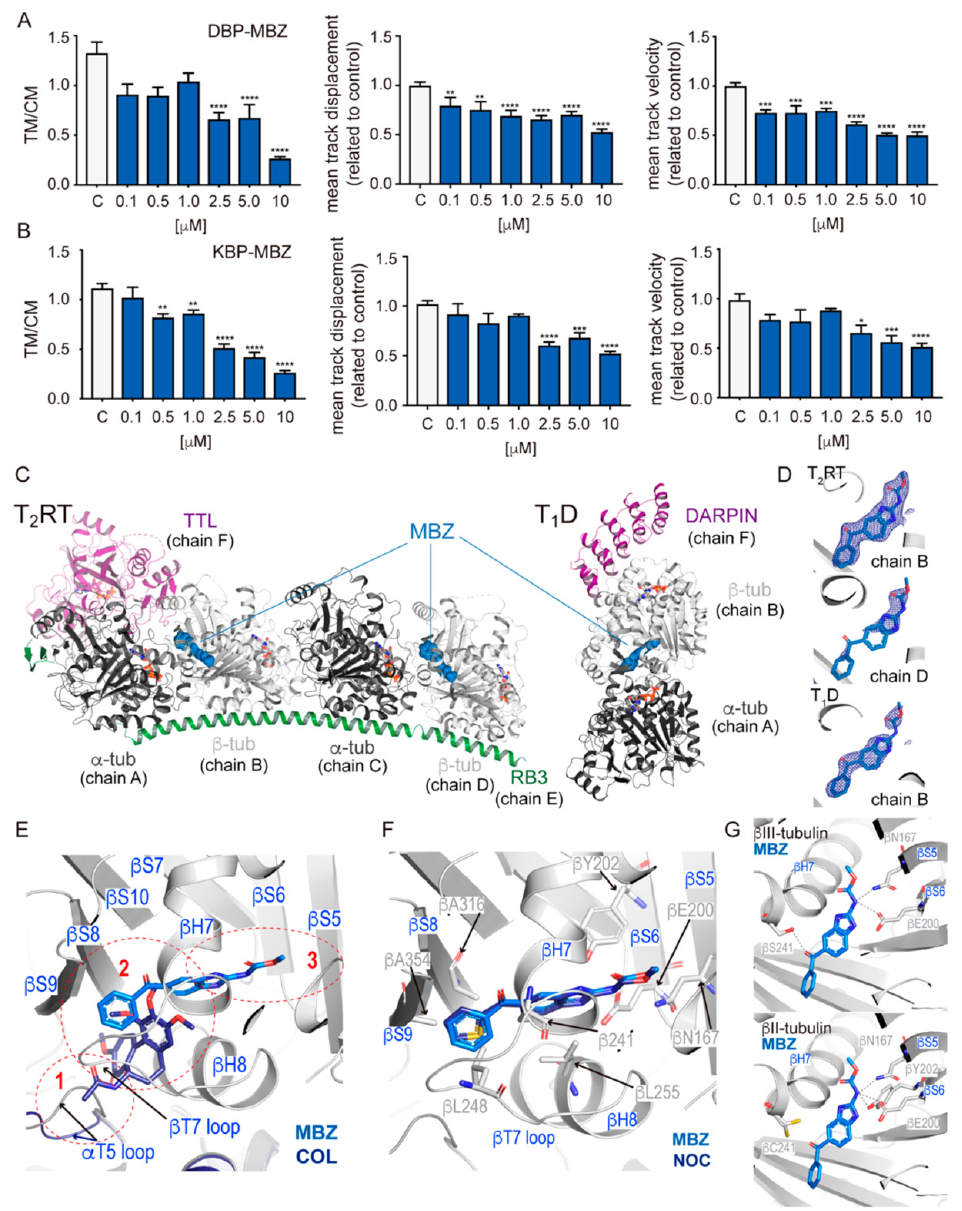
(Table S1). We found β II tubulin isotype in the T 2 R-TTL complex, and β III tubulin isotype in the T 1 D complex. The β II- and β III-tubulin isotypes share an overall sequence identity of 91% [43] with a single difference at the MBZ binding site, where residue 241 (helix H7) is a Cys ( β II) or a Ser ( β III).